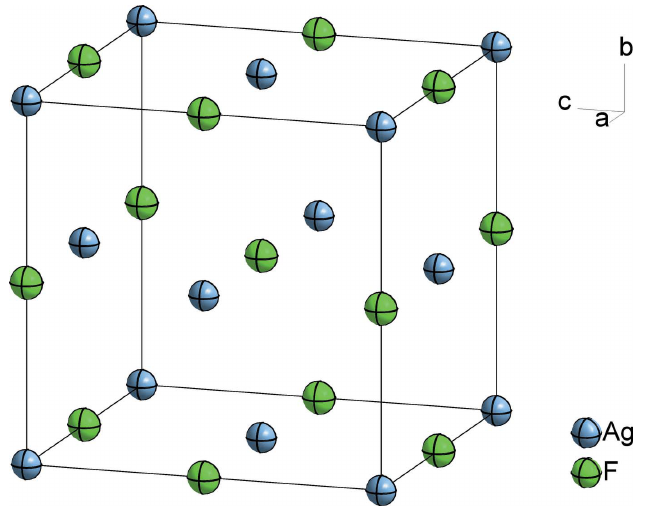
Figure 1 The rock salt-type structure of AgF. Displacement ellipsoids are drawn at the 50% probability level.